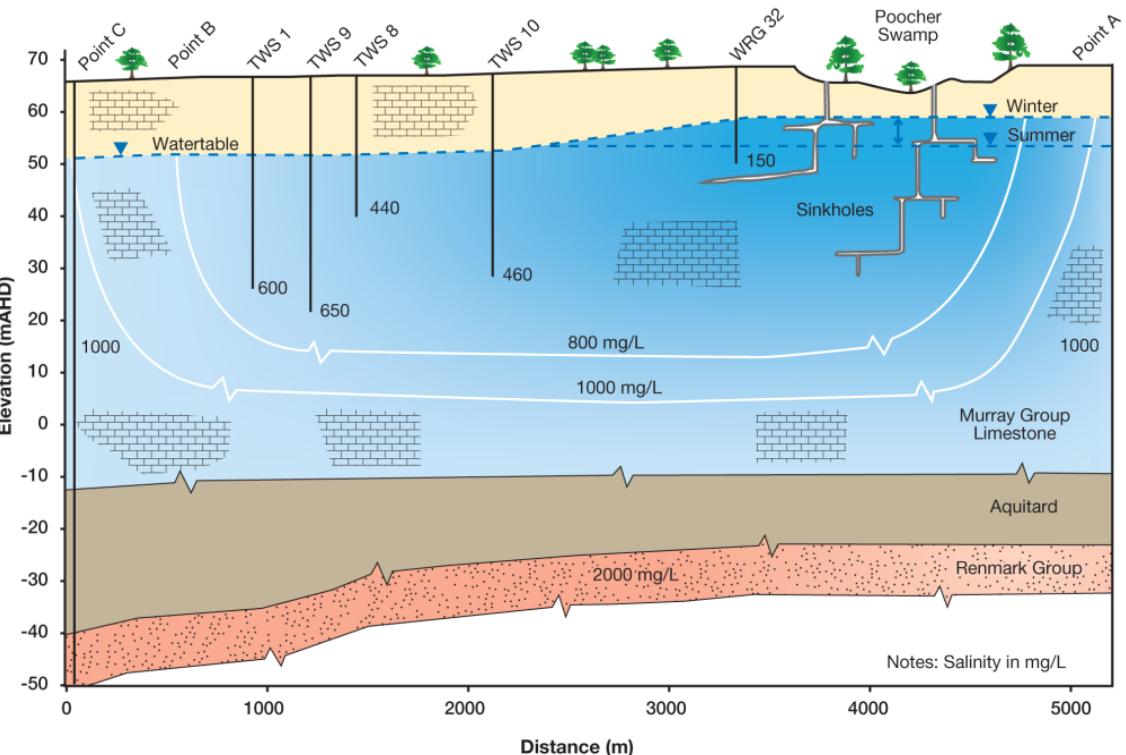
Figure 8. Cross section from point A to C in Figure 7—Poocher Swamp fresh water